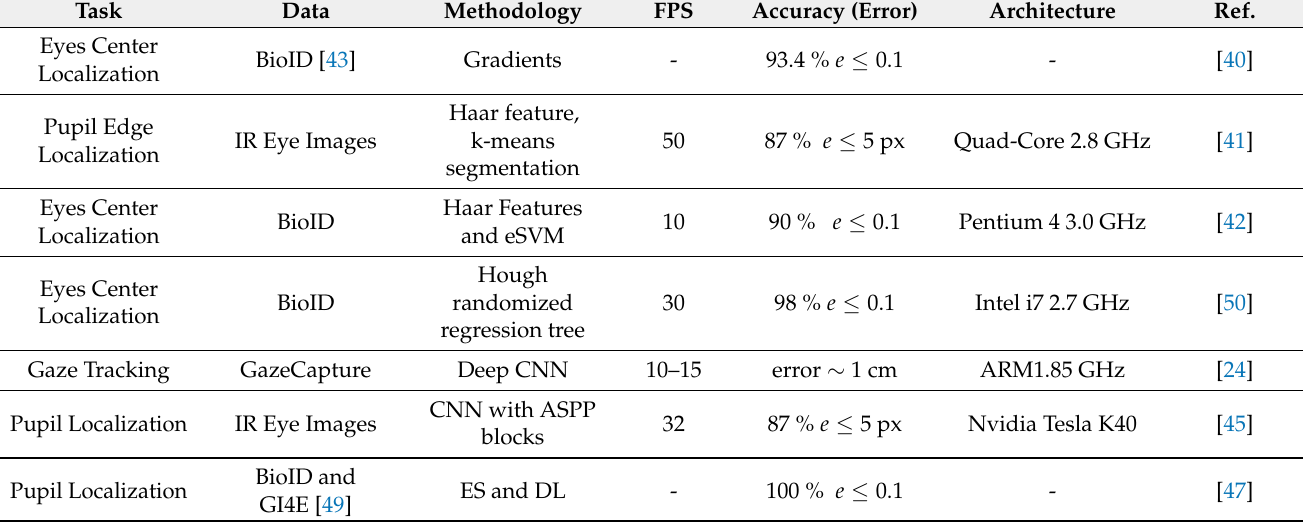
Table 1. Summarytable of related methods available in the literature for similar tasks of eye status classification. See Section 2 for further